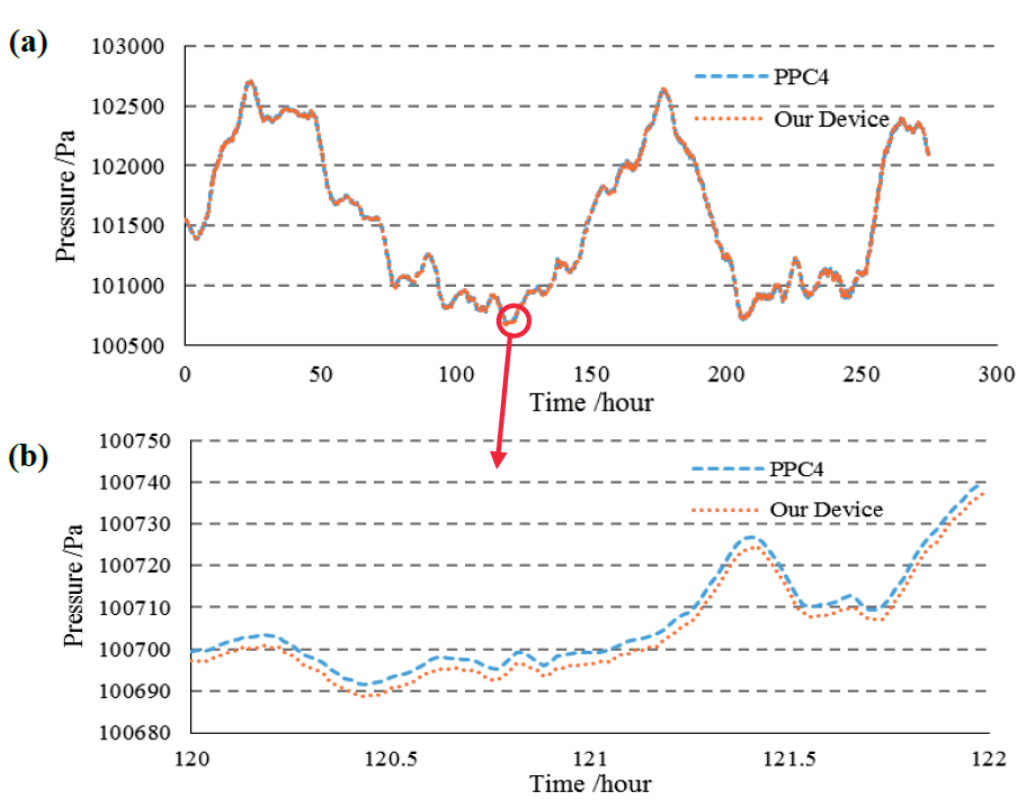
Figure 7. The actual atmospheric testing for a time duration of 270 h. ( a ) The device proposed in this study demonstrated comparable results with the pressure controller/calibrator during over 270 h of testing in the actual atmosphere; ( b ) The detailed experiments results where deviations lower than 8 Pa were